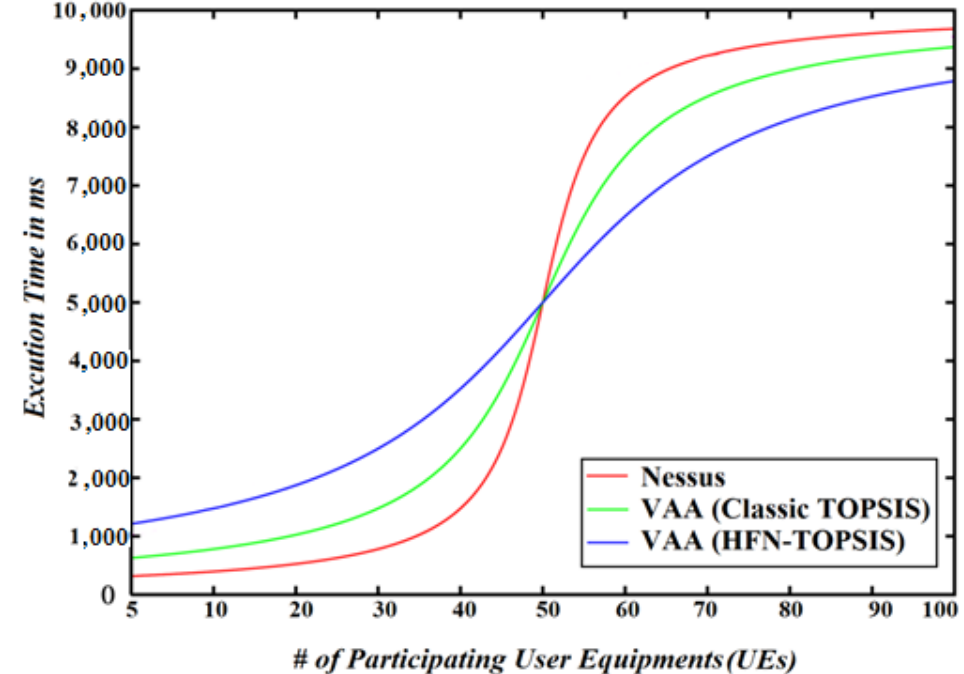
Figure 14. The scalability of the VAA and Nessus using a variant number of UEs.